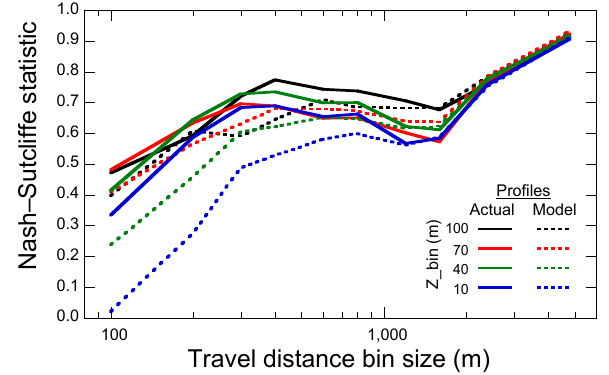
Figure 9. Model performance. Variation in Nash–Sutcliffe model efficiency statistic (Eq. 8) with size of travel distance and elevation bins, for modeled joint distributions of elevation and travel distance for Inyo Creek, using actual profiles (solid lines) and modeled pro- files (dashed lines). A Nash–Sutcliffe value of 1.0 indicates per- fect agreement between modeled and actual distribution of area; a value of 0 indicates model performance no better than uniform dis- tribution of mean area density. A tradeoff between model efficiency and spatial resolution is revealed by the trend toward higher Nash– Sutcliffe values for larger bin